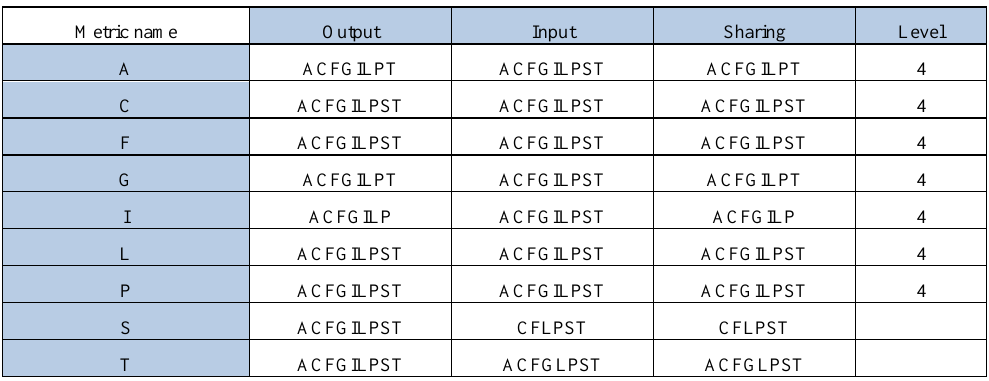
Table 7. Level 4 metrics